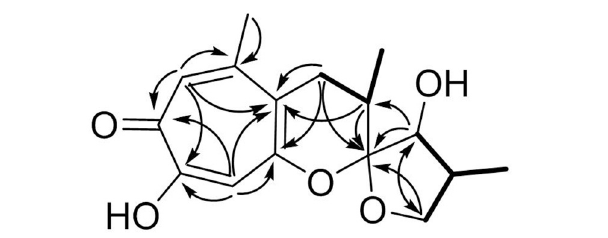
BIOLOGICAL ACTIVITIES